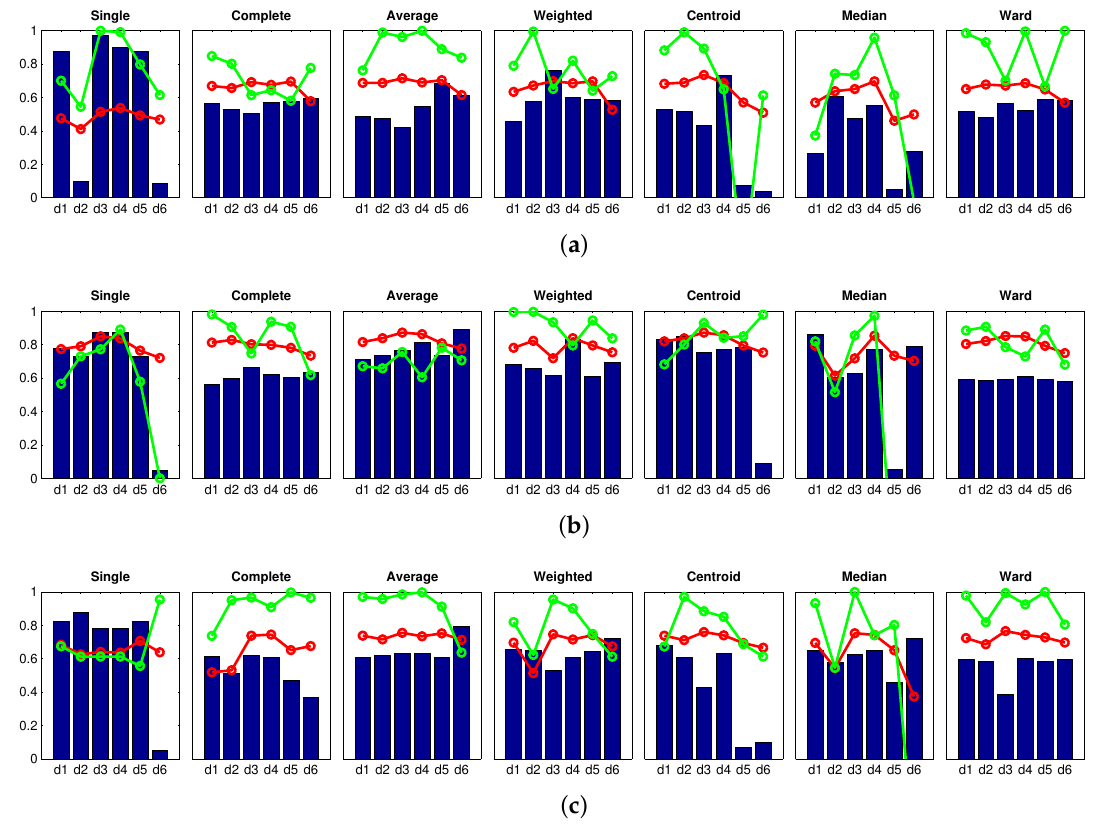
Figure 7. Legend: (cid:4) Accuracy c ; −◦− Correlation γ coph ; −◦− Inconsistency δ inconsist . Results of the high-level clustering using rotational PCA as global-appearance descriptor, k 3 = 50 and ( a ) N R = 4; ( b ) N R = 16; and ( c ) N R =